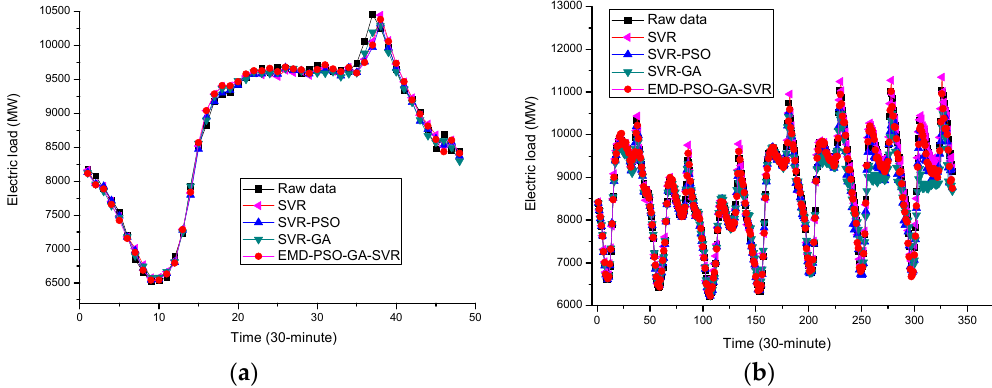
Figure 13. Forecasting performances comparisons (Example 1). ( a ) One-day ahead forecasting on 8 May 2007; ( b ) One-week ahead forecasting from 18 to 24 May 2007.